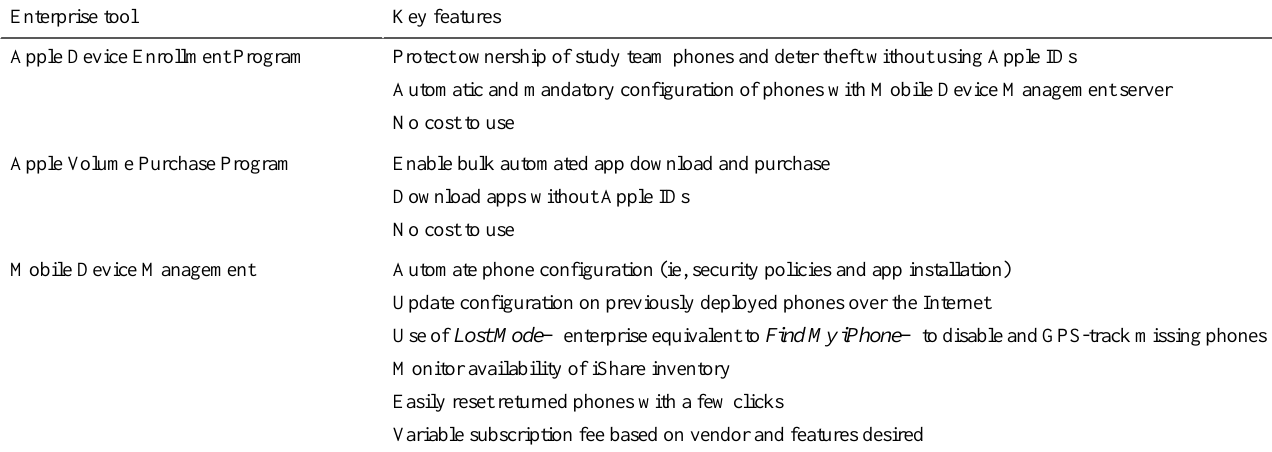
Table 2. Summary of enterprise tools adopted in iShare 3.0 and key benefits provided by each tool.